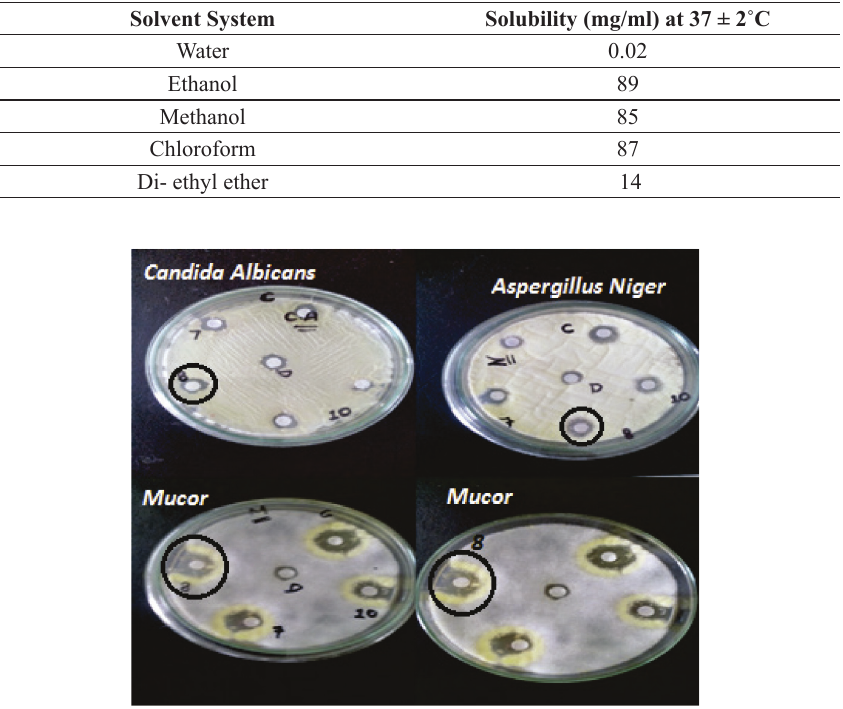
Figure 1 - Anti-fungal activity of clotrimazole gel (optimum formulation F8 is encircled).